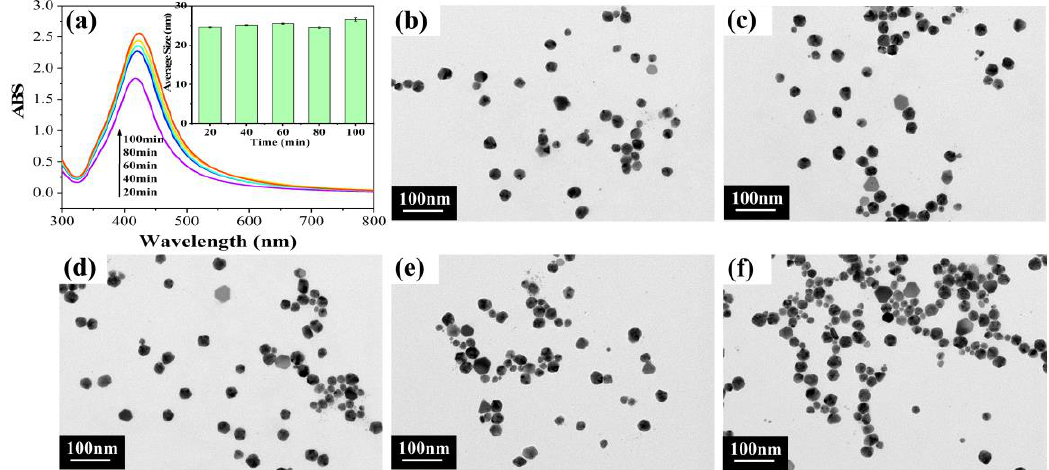
Figure 2. Results for different reaction times: ( a ) UV-vis spectra and (inset) average size histogram; ( b – f ) TEM images for reaction times of 20–100 min, respectively.